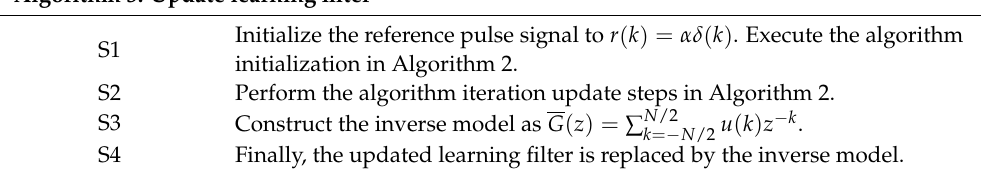
Figure 5. Schematic diagram of control algorithm learning filter updating structure proposed in this paper. Algorithm 3: Update learning